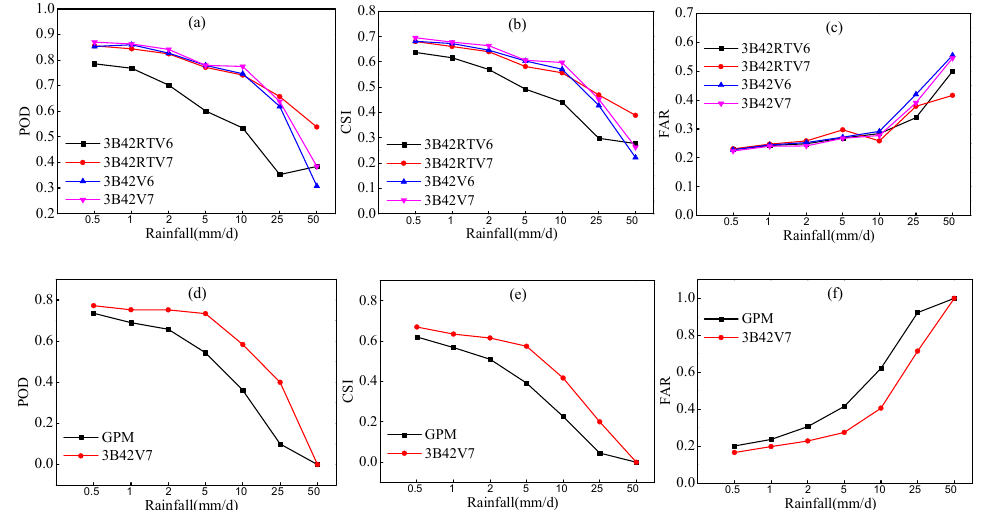
Figure 6. Statistical indices for different rainfall thresholds at daily time scale (( a , d ) POD; ( b , e ) CSI and ( c , f ) FAR).